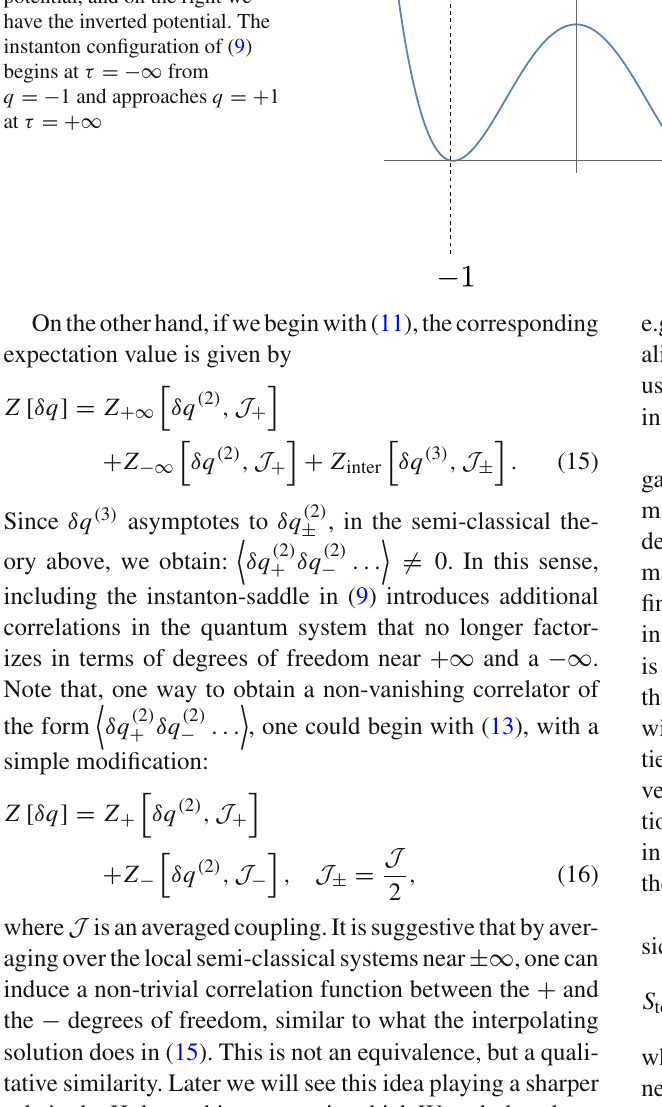
Fig. 1 A schematic diagram for the instanton configuration. On the left, we have the original potential, and on the right we have the inverted potential. The instanton configuration of (9) begins at τ = −∞ from q = − 1 and approaches q = + 1 at τ =